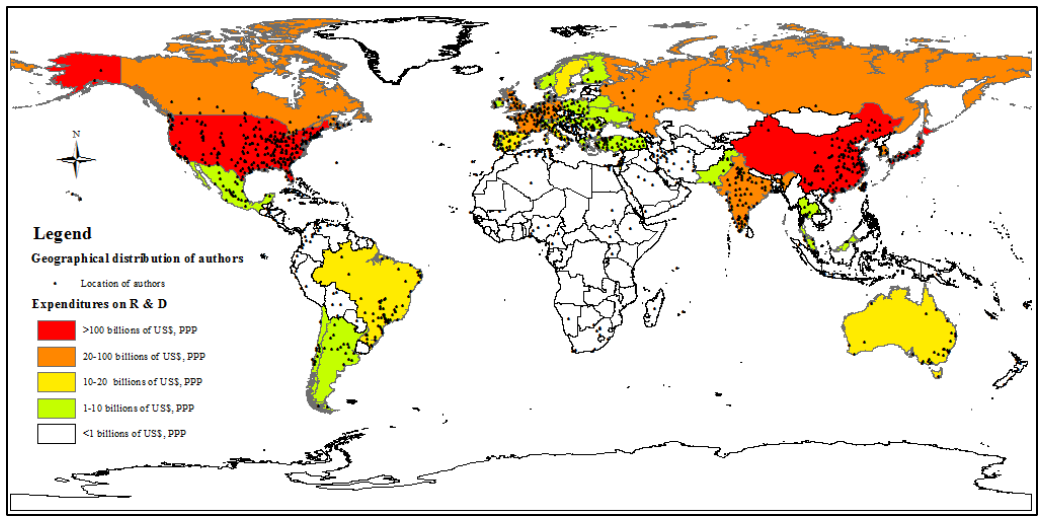
Figure 3. Kernel density estimation for the geographic distribution of authors